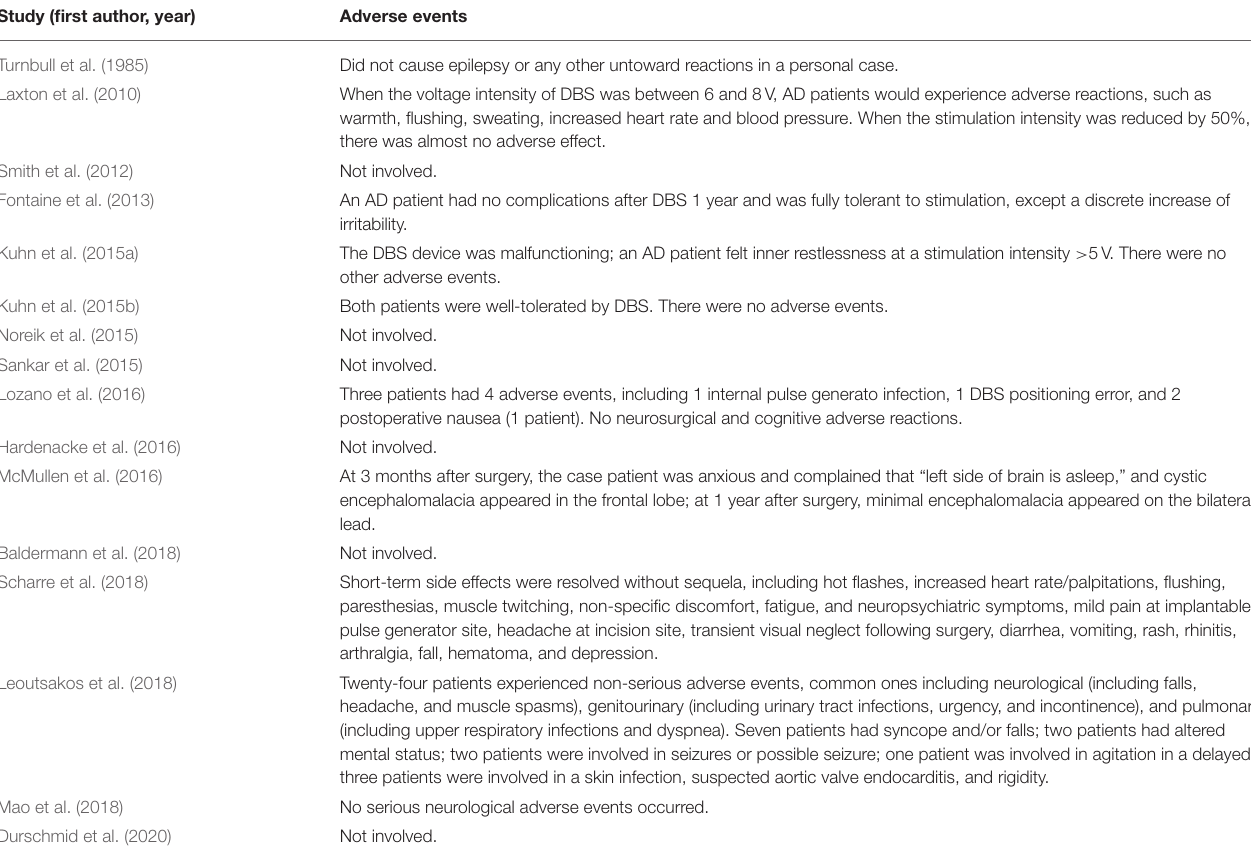
TABLE 3 | Adverse events of the human clinical study of DBS in